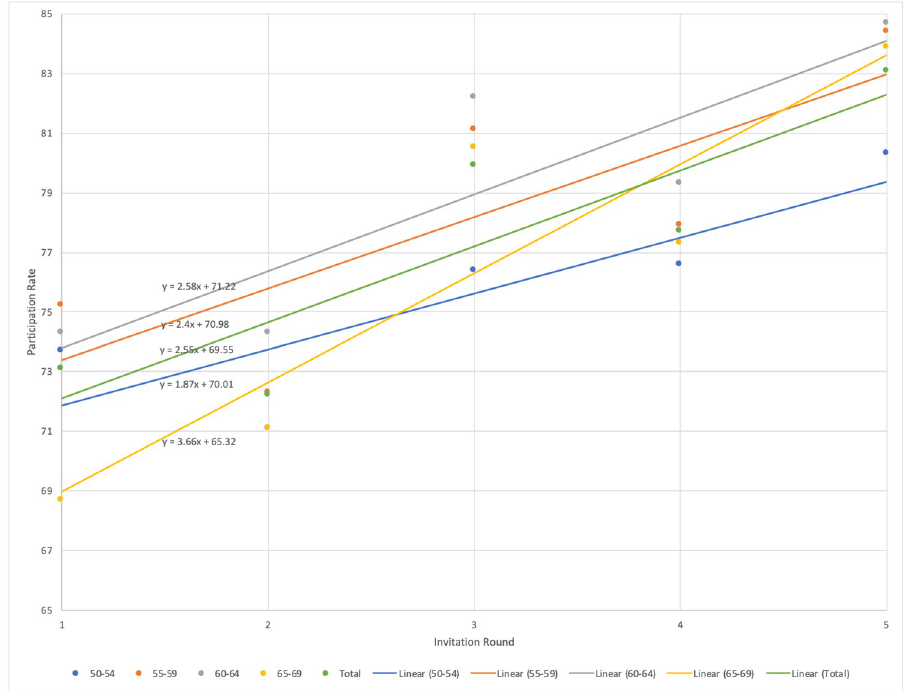
Fig 1. Linear model of mammography screening participation rates among the four age groups and the total group in the Capital Region of Denmark from 2008–2017 (color needed).